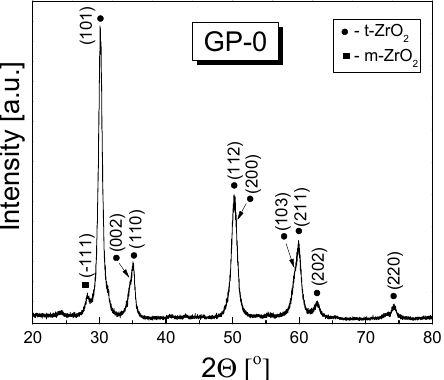
Figure 1. XRD pattern recorded for the 3-YSZ powder obtained by calcinating the precursor gel with no alumina addition for 2 h in air at 873 K (sample GP-0).